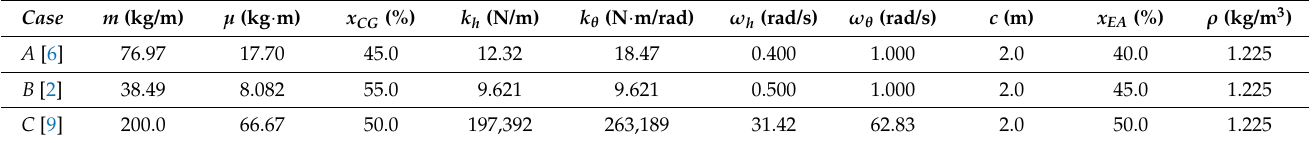
Table 2. Aero-structural properties of test cases from the literature for flutter of a typical section in incompressible flow.